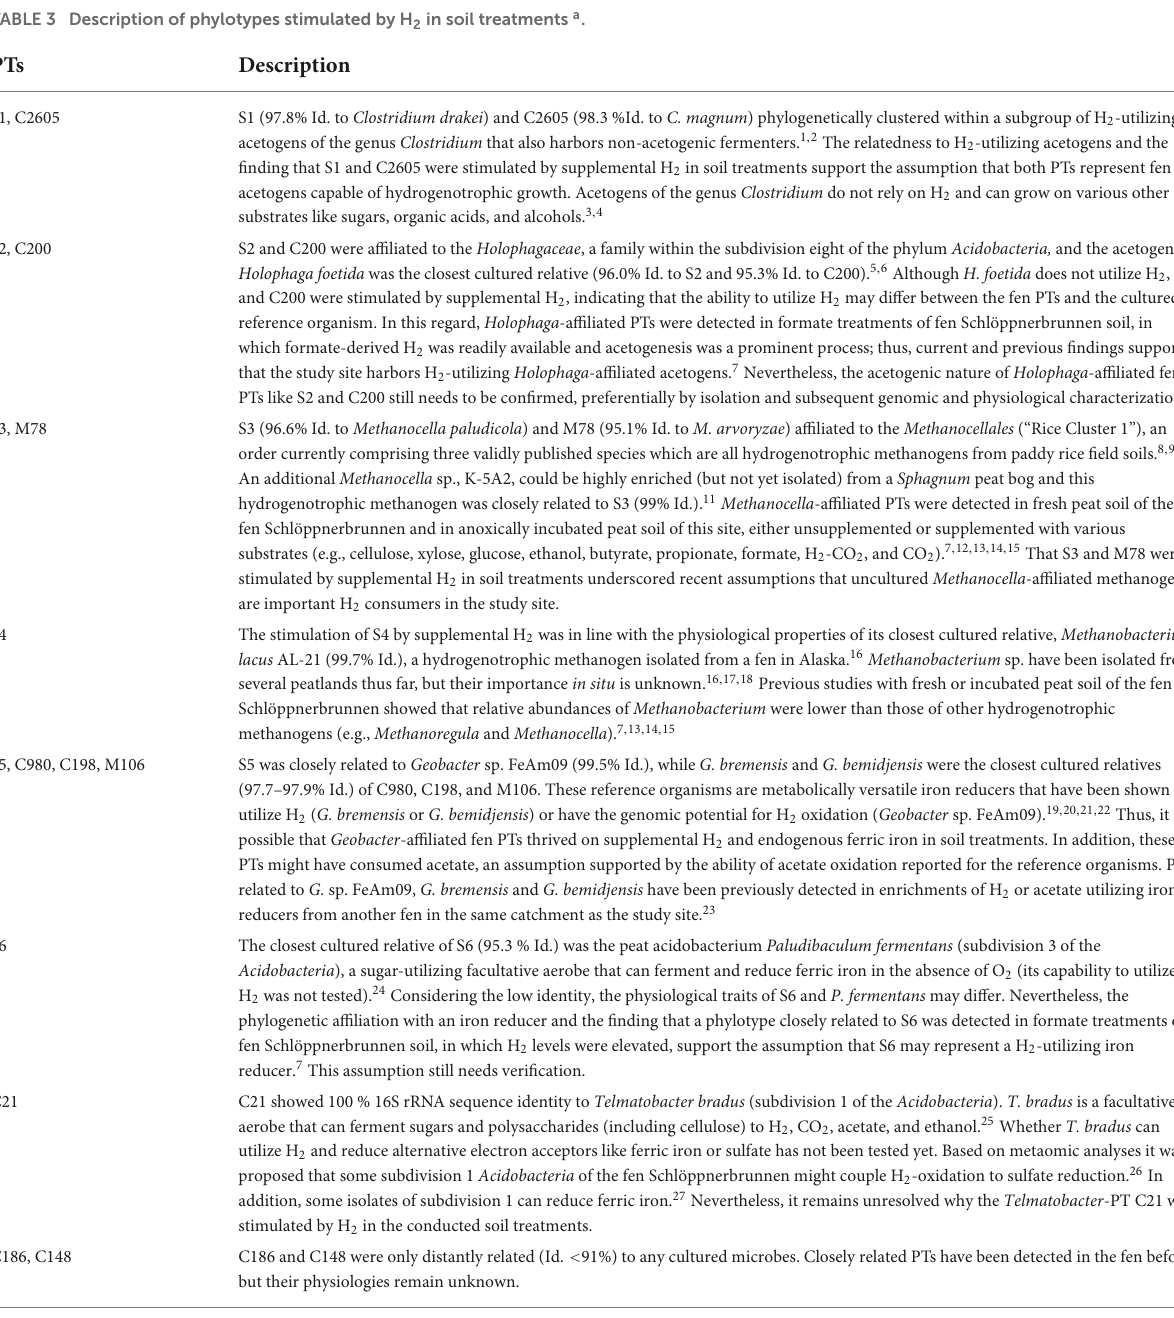
TABLE 3 Description of phylotypes stimulated by H 2 in soil treatments a